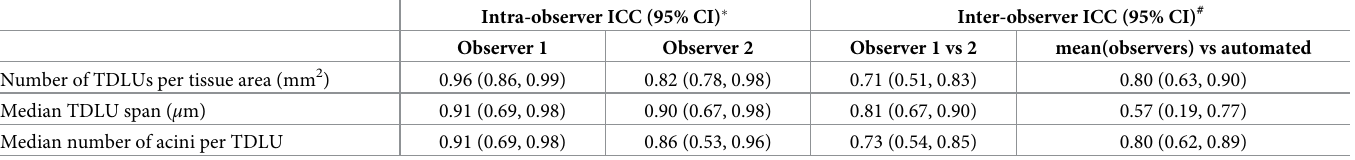
Table 2. Inter- and intra-observer intraclass correlation coefficient (ICC) scores and the 95% confidence interval (CI) for the quantitative terminal ductal lobular unit involution measures obtained from two observers and the automated